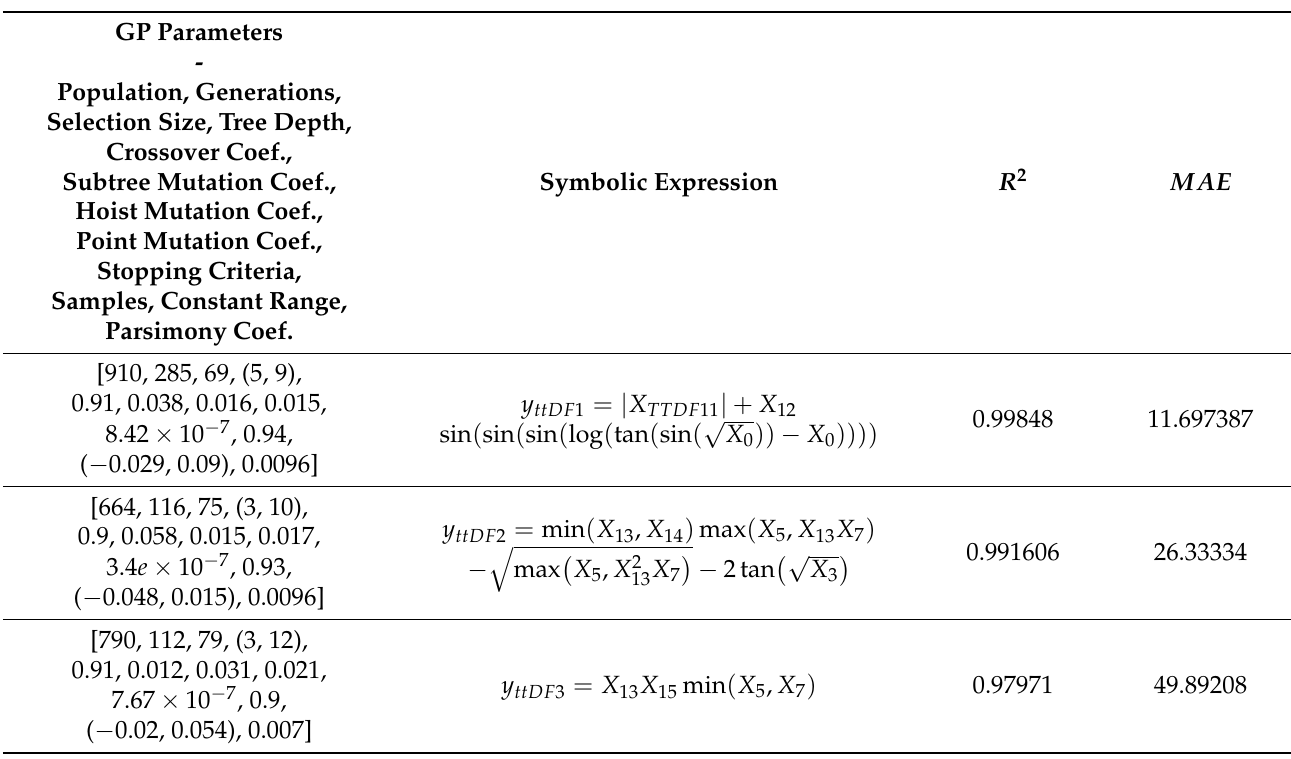
Table 12. Three best symbolic expressions for total propeller torque estimation with decay state coefficients with corre- sponding R 2 and MAE score.